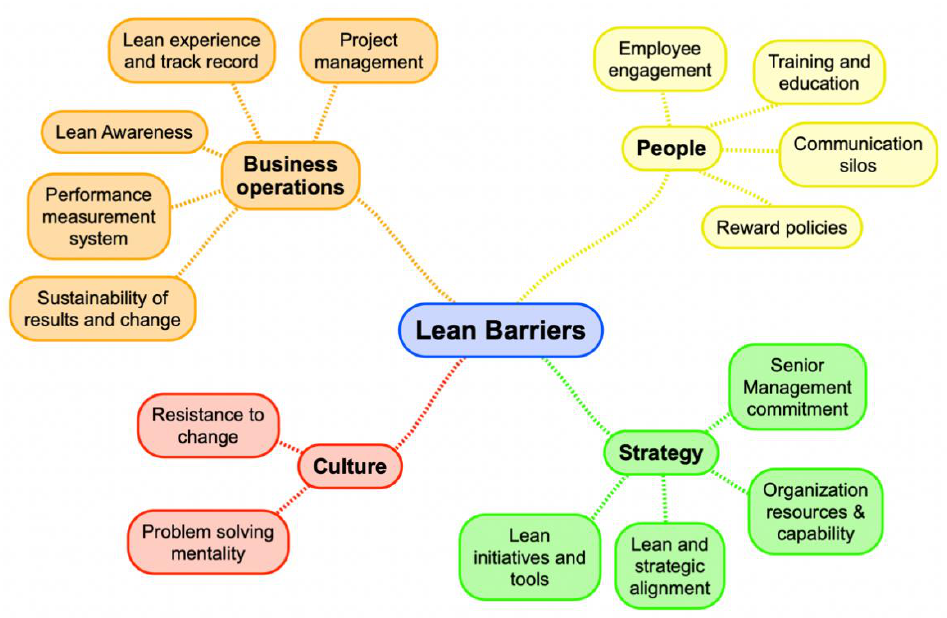
Figure 2. Lean barriers classification.